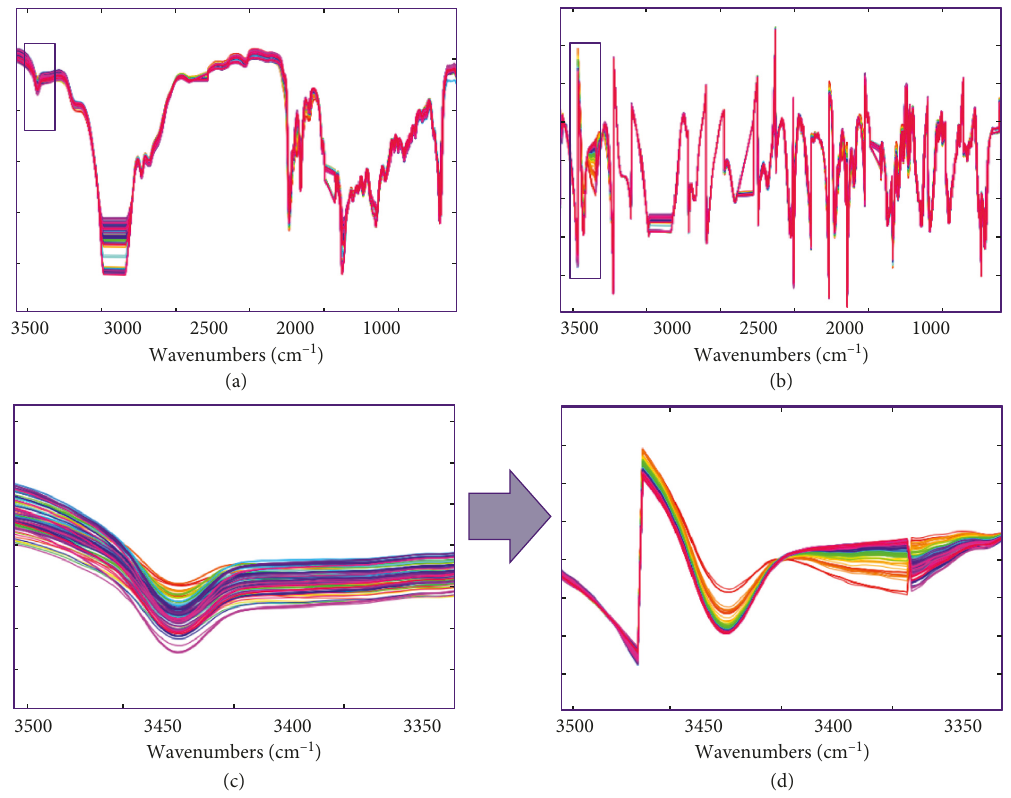
Figure 5: Demonstration of the improvement of peak alignment for DLSNV. (a) SNV-transformed transmission spectra with marked zoom level of (c). (b) Optimized DLSV spectra with marked zoom area of (d). Magenta indicates (relatively) fresh samples, whereas red indicates a strong degradation level.